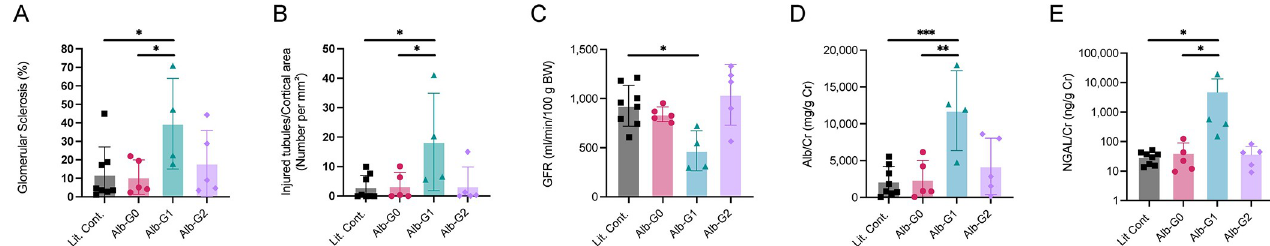
Fig 4. Circulating risk variant APOL1 causes kidney dysfunction and tubular damage. (A, B) Transgenic Alb/APOL1-G1 mice had a significantly higher amount of glomerular sclerosis and tubular injury. Kidneys were evaluated after being stained with periodic acid-Schiff stain. (C) Transgenic Alb/APOL1-G1 mice demonstrated reduced measured glomerular filtration rate (GFR) at day 10. Clearance of intravenously or retro-orbitally administered FITC-sinistrin was used to quantify glomerular filtration in mice on day 10 of the triple intervention. (D, E) Transgenic Alb/APOL1-G1 mice have higher albumin-to-creatinine ratio (Alb/Cr) and NGAL-to-creatinine ratio (NGAL/Cr). Urine concentrations of albumin, NGAL, and creatinine were determined on day 14 of triple intervention therapy. Data are presented as mean ± SD. Statistical significance was determined by Student’s t-test. � P < 0.05, �� P < 0.01, ��� P < 0.001.